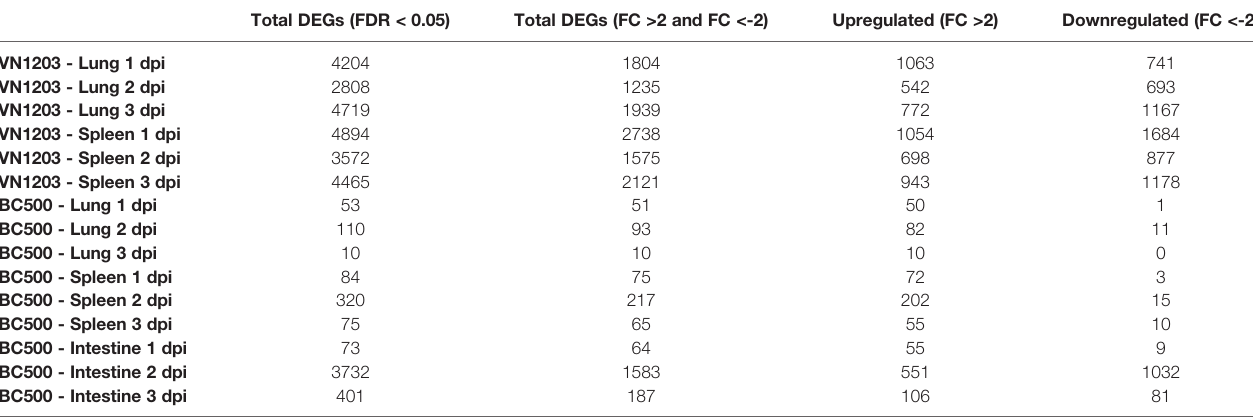
Total DEGs were sorted by false discovery rate (FDR) <0.05. Genes were considered upregulated if the log2(FC)>1 and downregulated if the